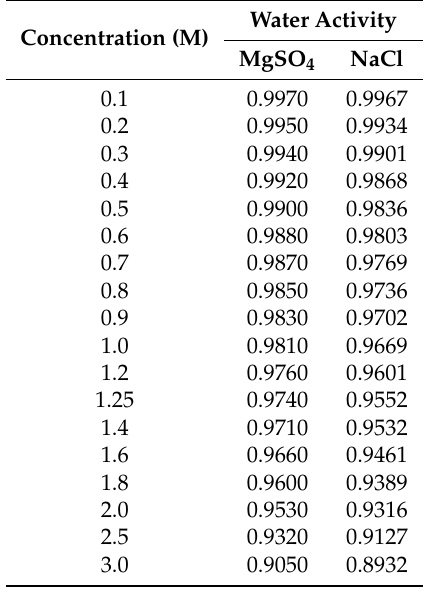
Table 2. Water activities of aqueous solutions of MgSO 4 and NaCl at T = 25 ◦ C. The data are taken from References